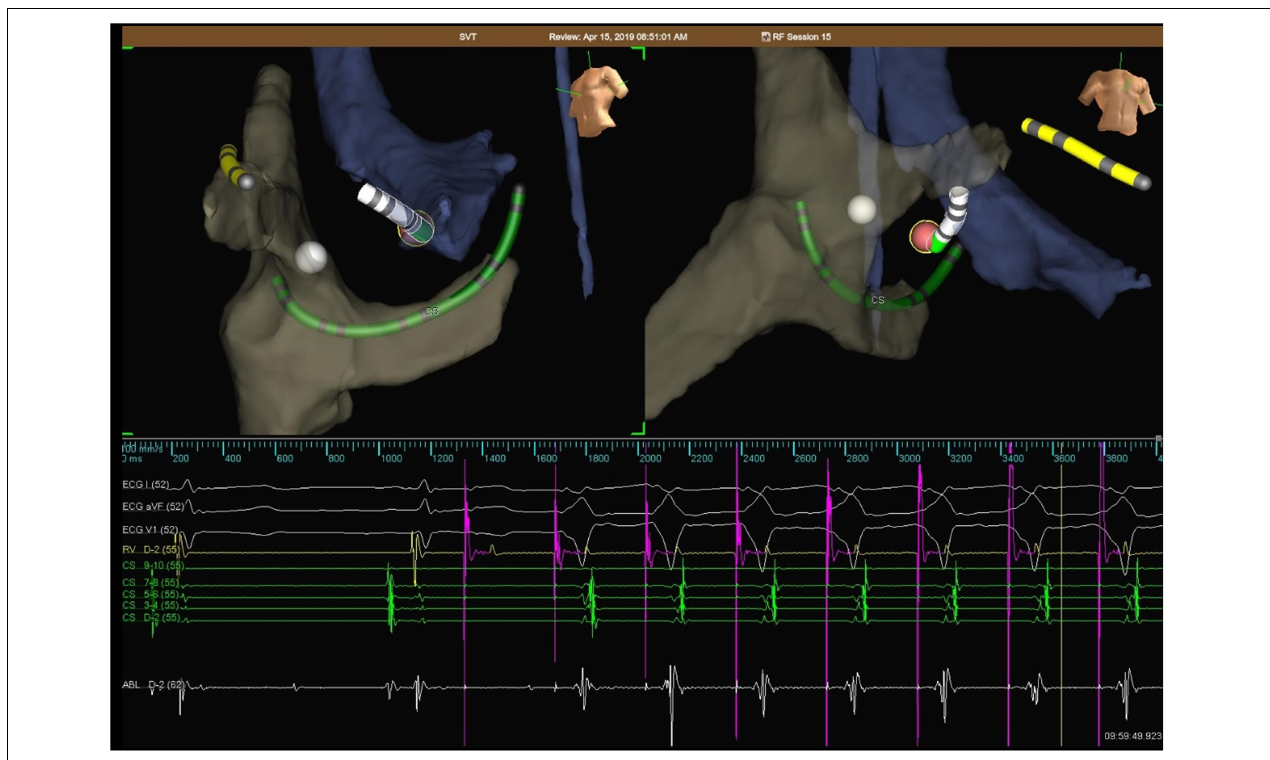
FIGURE 1 | Representative electroanatomical map during ablation of left -sided AP via TA in a child. Catheters are placed by the aid of NAVX, showing a small A and a large V, having AV fusion during ventricular pacing. The white tag represents the His region, while red tag represents ablation point. AV separation indicates that ablation is